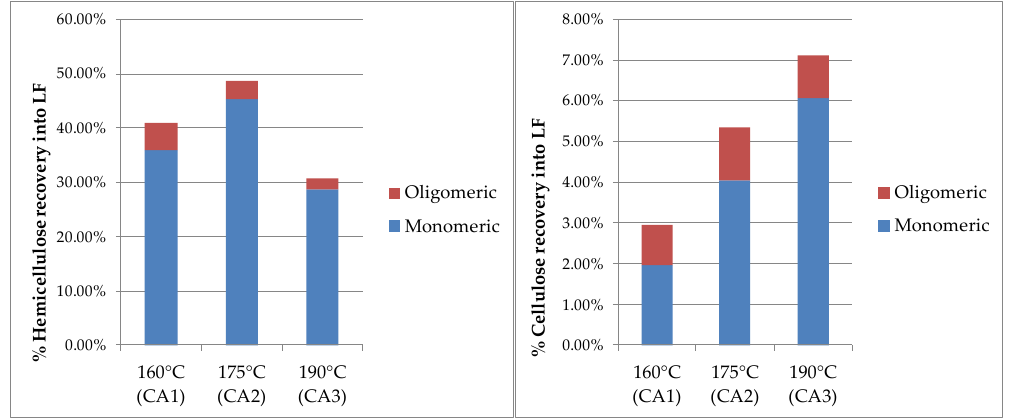
Figure 2. Mono- and oligosaccharides of cellulose and hemicellulose recovered in the LF.